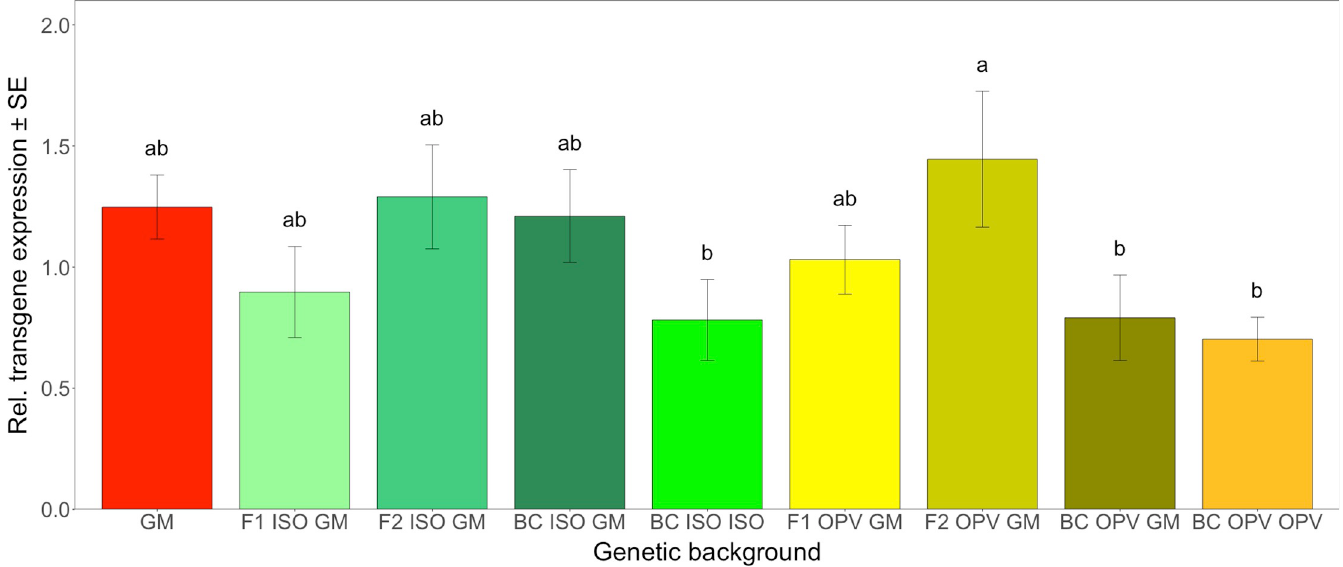
Fig 2. Mean transgene expression (transcription activity) in different genetic backgrounds from South Africa. Vertical bars show mean values, with the standard error ( ± SE) indicated as lines. Letters above the bars represent results from the means separation Duncan’s test.